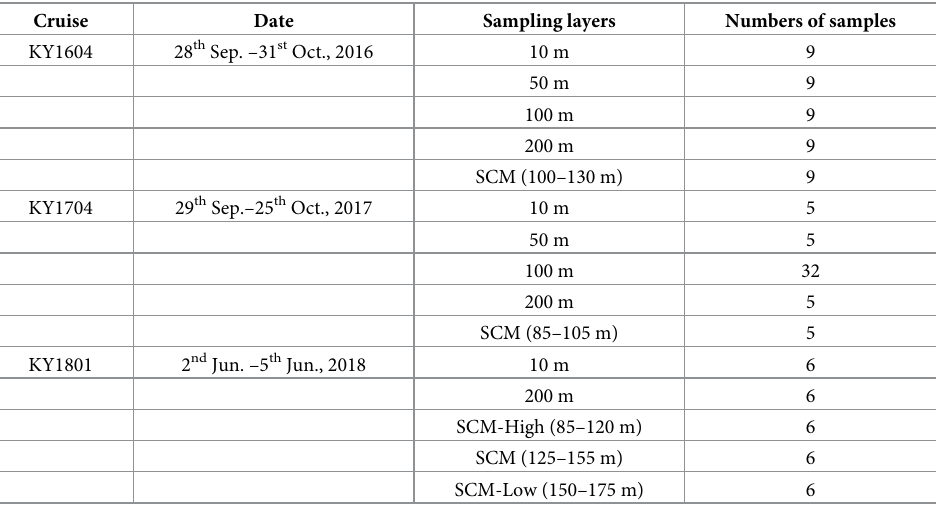
Table 1. List of the sampling layers and numbers in three cruises. Cruise Date Sampling layers